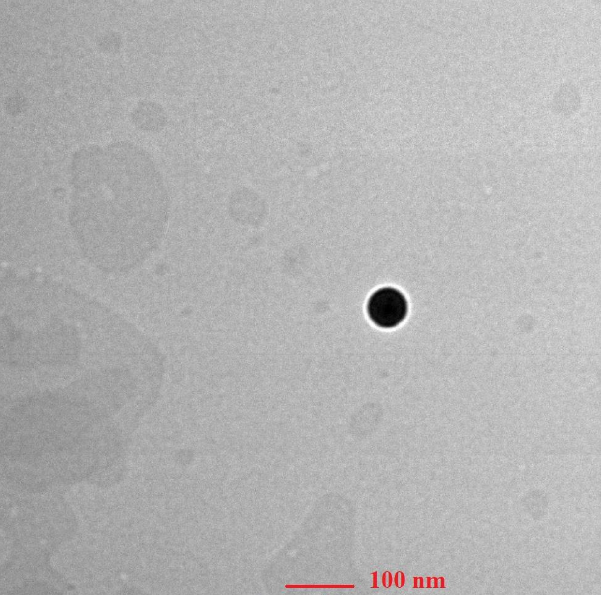
Figure 5. TEM images of ethosomal vesicles depicting size below 100 nm.